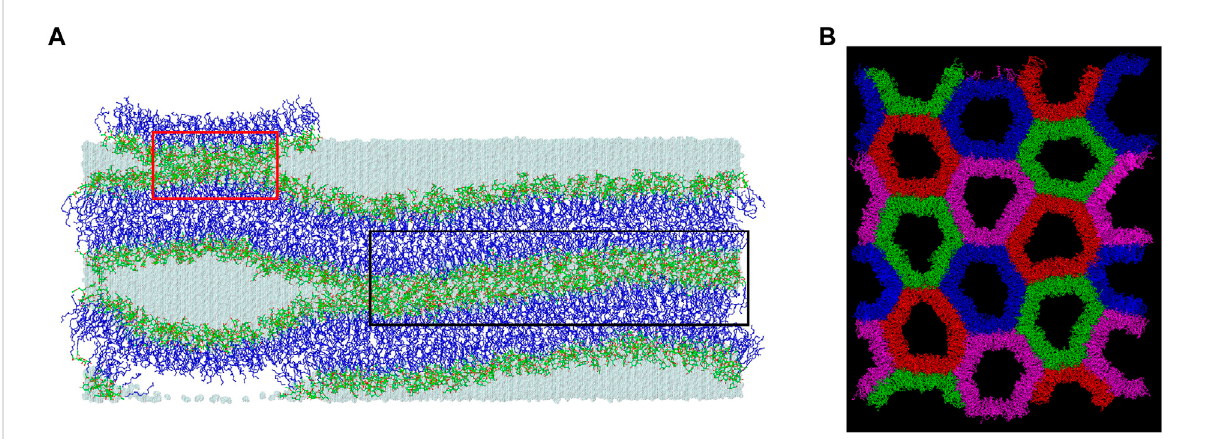
FIGURE 4 Three regions of W15 and top view of the H II phase. (A) The concave region is not marked; the larger connect-15 region formed through the “ inner ” water layer(15H 2 O/MGDG)ismarkedwith a black frameand thesmallerconnect-30 regionnewly forming overthePBCthroughthe water layer (30 H 2 O/MGDG) is marked with a red frame. The atoms are represented in standard colours, except for the acyl chain carbon atoms which are dark blue . The water is shown as a transparent blue surface. The hydrogen atoms are not shown. (B) Top view of the H II phase generated Ref. (Bratek et al., 2019) after 3 µs of MD simulation. The water- fi lled cylinders are in different colours to show the H II phase structure better. The water molecules are not